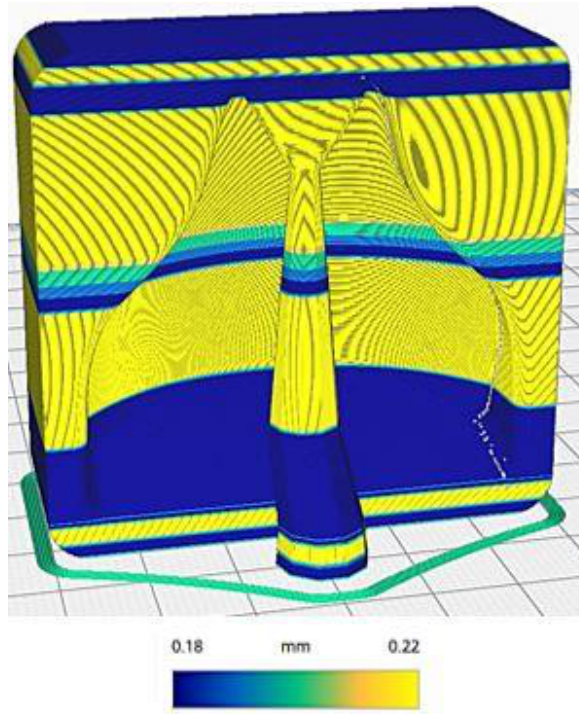
Figure 5. Preview of variable layer height.